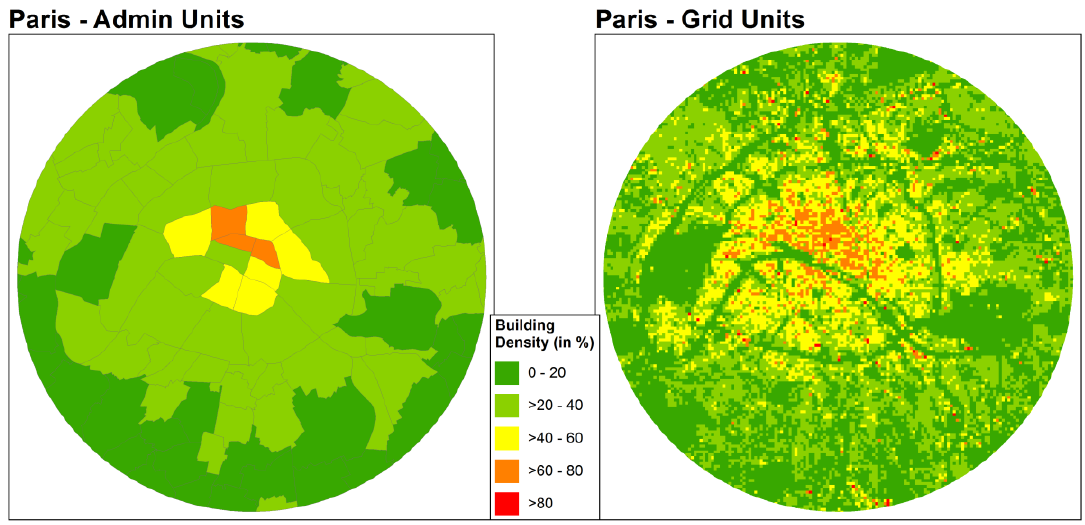
Figure 5. Building density maps related to different reference units: grid vs. administrative units.